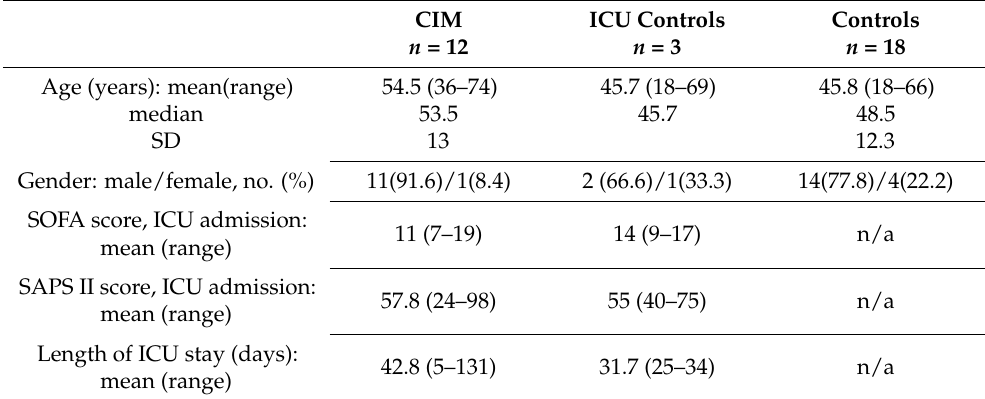
Table 2. Characterization of patients within groups: ICU patients with and without CIM and controls.